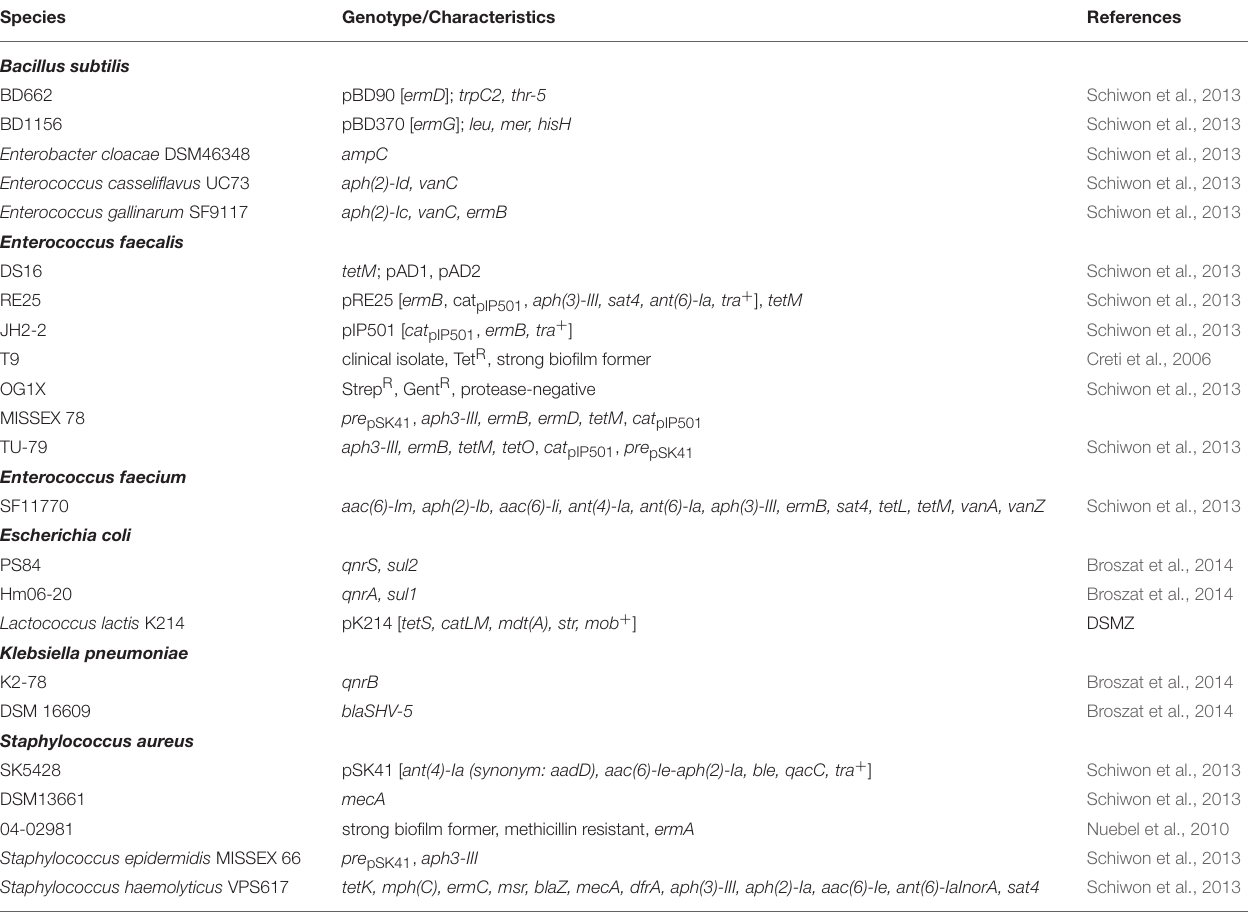
TABLE 1 | Bacterial species used as references for AB-R-screening, biofilm formation, plasmid isolation, and in biparental